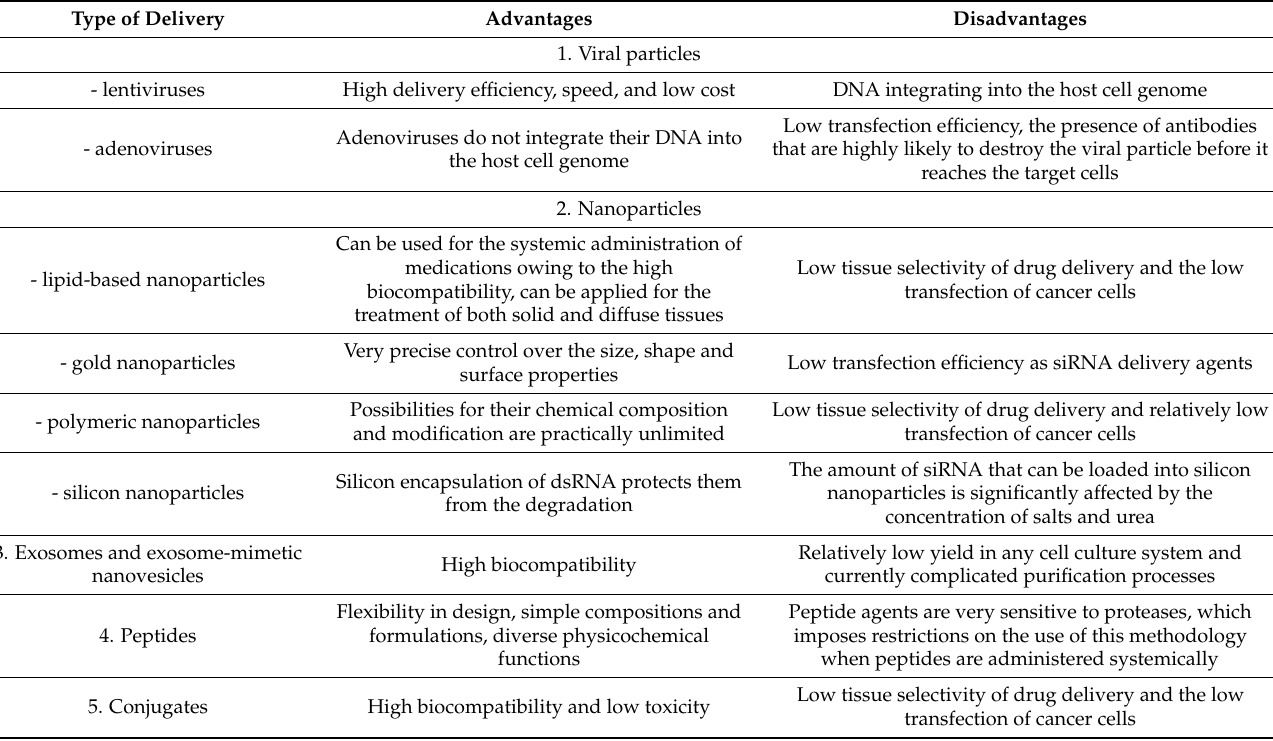
Table 1. Short summary of methods for exogenous RNA